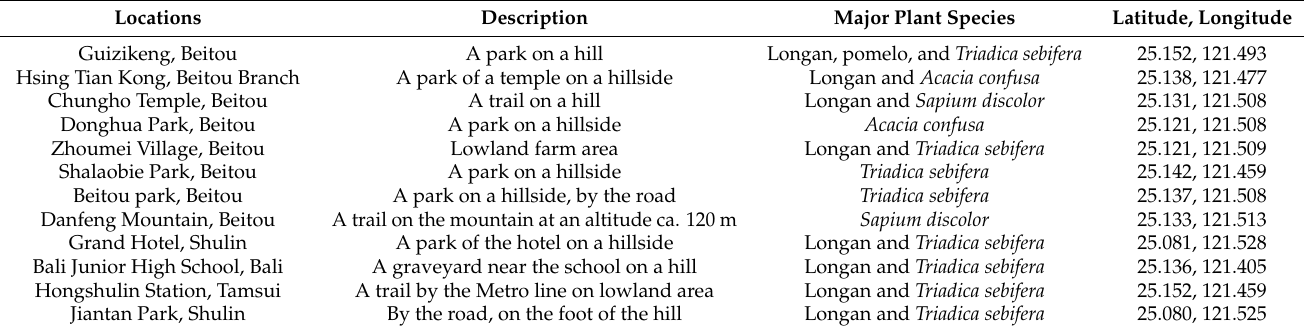
Table 1. Description of the locations recorded with the egg masses or nymphs of Pyrops candelaria in northern Taiwan, from 30 April to 20 July 2021.